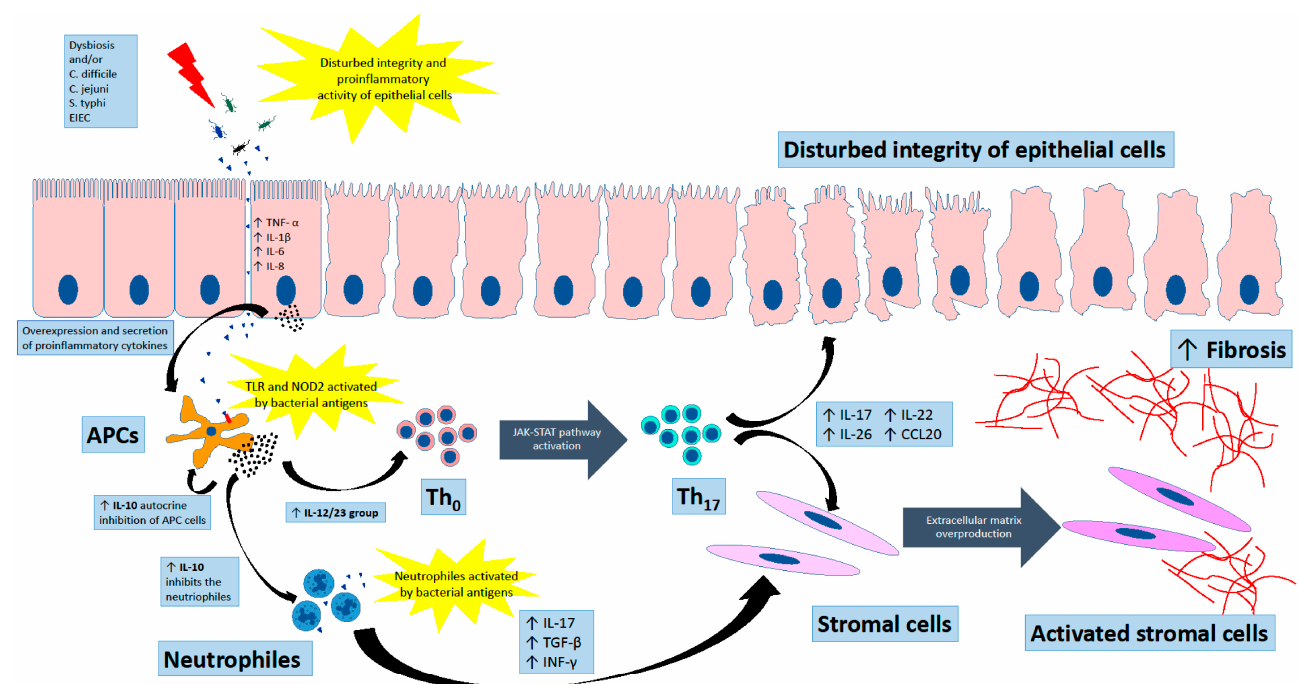
Figure 1. Pathogenesis of inflammatory bowel diseases (IBDs). The dysbiosis of gut microbiota is a cause of exacerbation of the disease and determines the severity of the mucous inflammation. It causes the imbalance in the integrity of epithelium barrier and promotes infection of, i.e., C. jejuni , S. typhi , enteroadherent or serotypes enteroinvasive of E. coli (EIEC). By stimulating membrane Toll- like receptors (TLR) and intracellular NOD receptors (nucleotide-binding oligomerization domain proteins, NOD1, NOD2) in immune cells, including antigen-presenting ones (APCs), the cytokine pathway of the cellular immune response and tissue secondary remodeling is activated. The important role is played by Th17 lymphocytes derived from naive Th0 lymphocytes under control of IL23 and IL12. The cytokine mediated signal transmission through JAKSTAT pathway ultimately activates Th17 cells, which are the source of several pro-inflammatory cytokines: IL17A, IL17F, IL22, IL26, and the chemokine CCL20. In addition, the IL-10 affects the activity of Th17 lymphocytes inhibition which are donors of IL17, IL23, IL6. As well as the IL10 has the ability to inhibit the APCs by reducing the expression of major histocompatibility complex (MHC) and to control another level of adaptive immune answer. The IL17, IL23, IL6 and TGF- β , INF- γ are involved in the recruitment of neutrophils in inflamed tissue and in the activation of mesenchymal cells that play a major role in fibrosis in IBD.